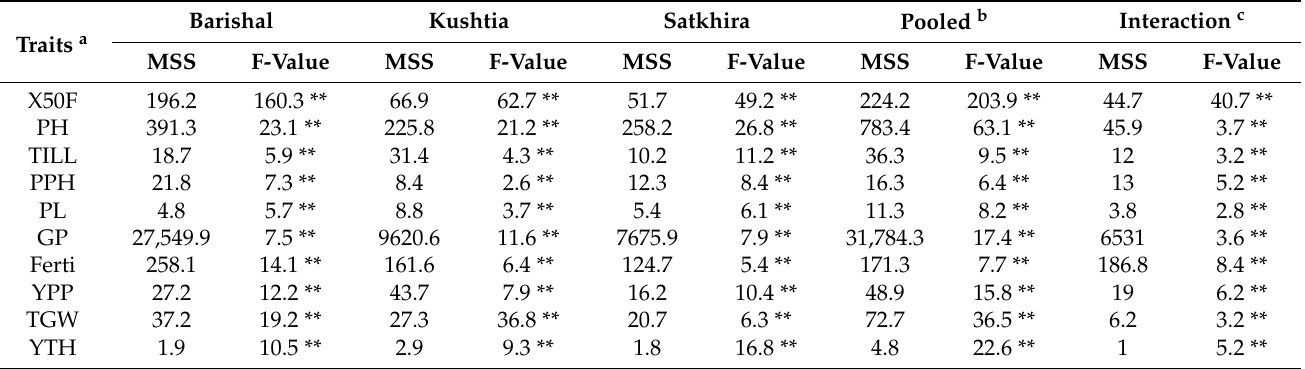
Table 3. Combined analysis of variance, mean sum of square (MSS) and F-value of the ten traits, and their interaction in elite rice breeding lines in studied